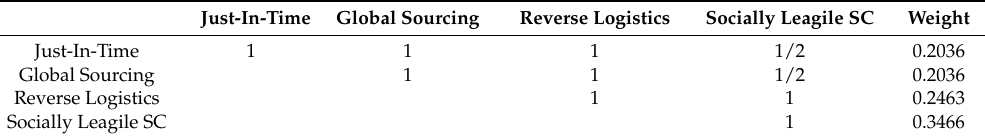
Table A14. Pairwise Comparison of Alternative w.r.t. sub-criterion Workplace safety &